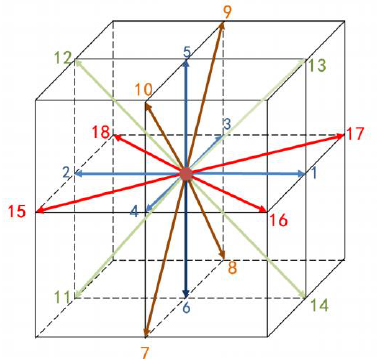
Figure 8. Schematic diagram of D3Q19 model.